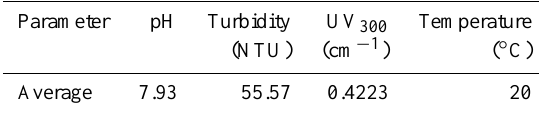
Table 1. Raw water characteristics.